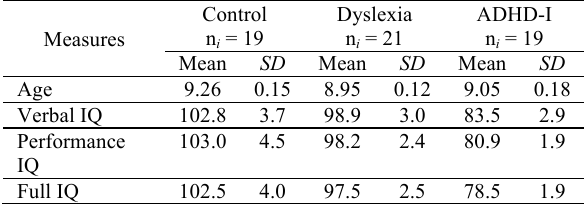
Table 1 – Group mean for age and IQ.